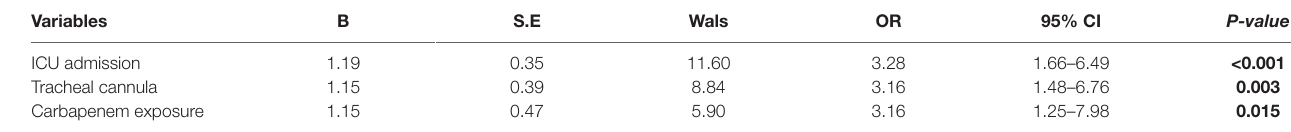
TABlE 4 | Multivariate analysis of risk factors for infection with extensively drug-resistant Klebsiella pneumoniae (XDR-KP) and non-XDR-KP. Variables B